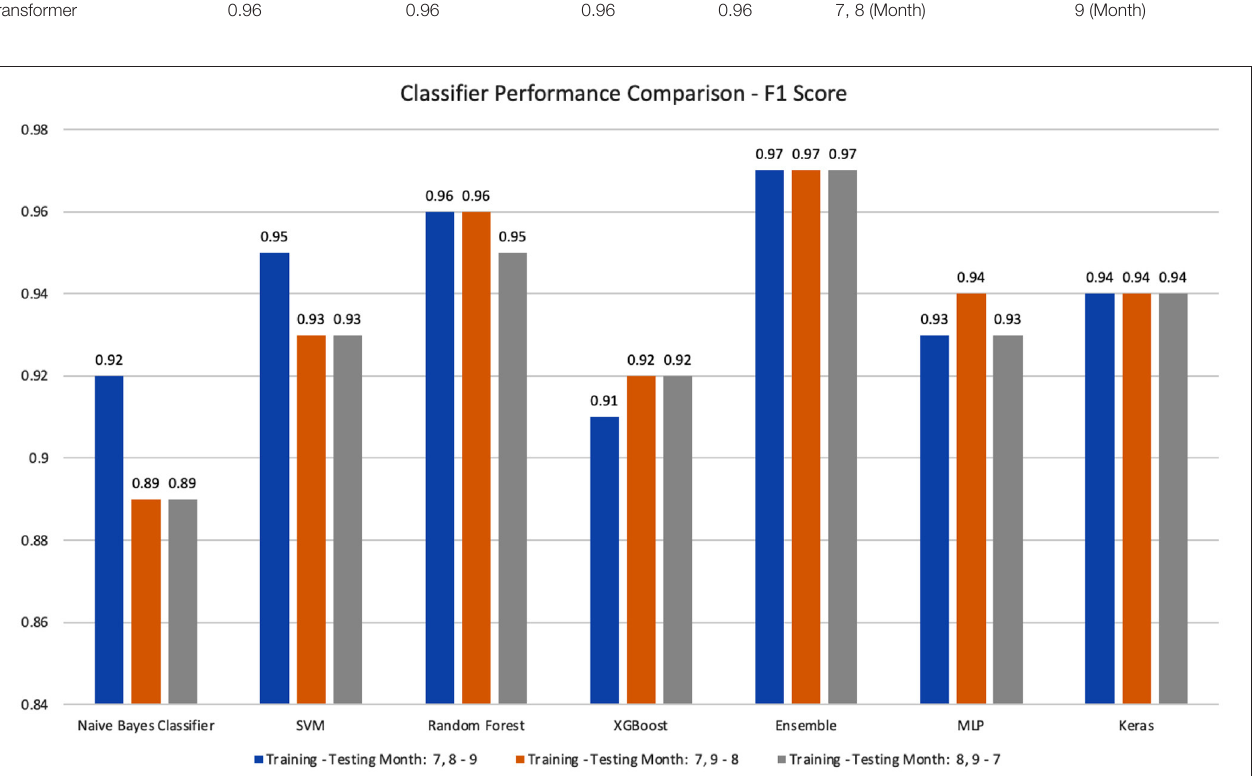
FIGURE 2 | The performance comparison for all classifiers based on different month-based training-testing